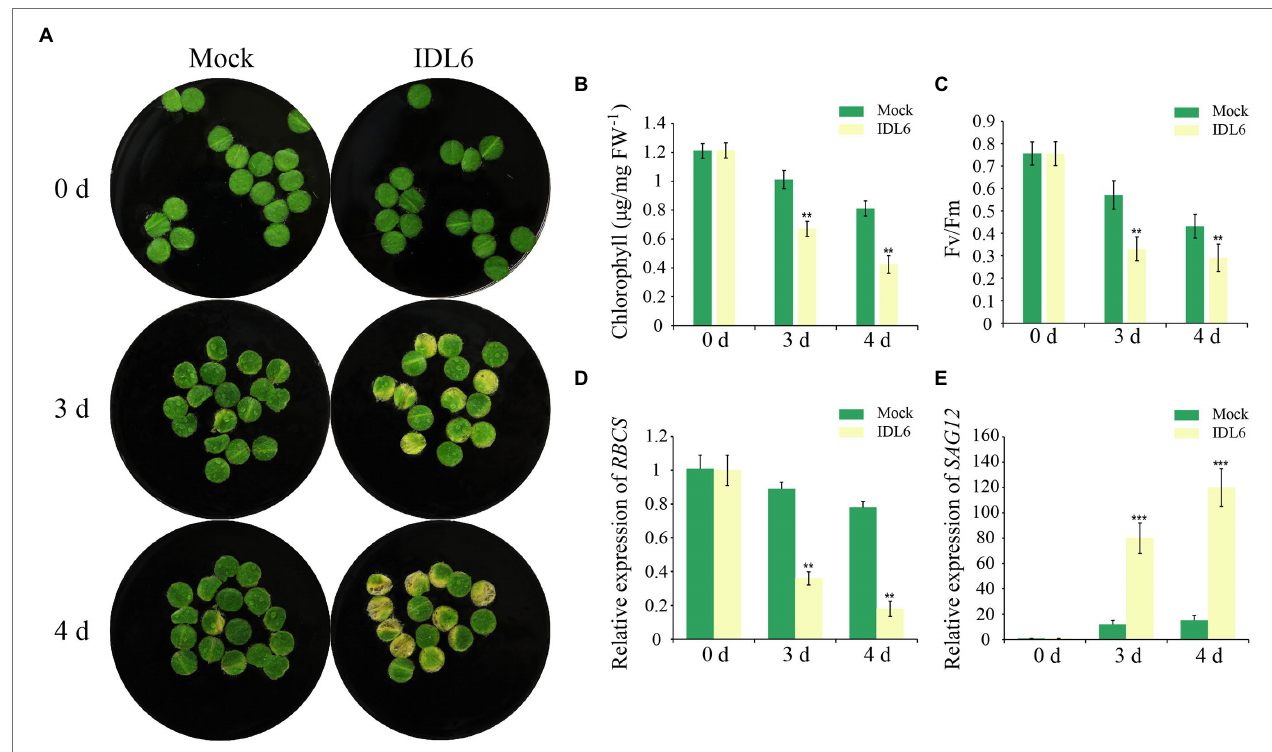
FIGURE 3 | The senescence phenotypes of detached leaves treated with synthetic IDL6 peptides. (A) The detached leaves from wild type of Arabidopsis exhibited early senescence under IDL6 EPIP peptide treatments. Leaves were kept in a growth chamber at 23 ° C with continuous light. Changes in chlorophyll content (B) and photosynthetic rate (C) in the treated leaves. The relative expression of RBCS (A) and SAG12 (E) in leaves from each group. Error bars indicate the SE ( n > 10). Significant difference compared with the Mock was determined by Student’s t -test (** p < 0.01 and *** p <